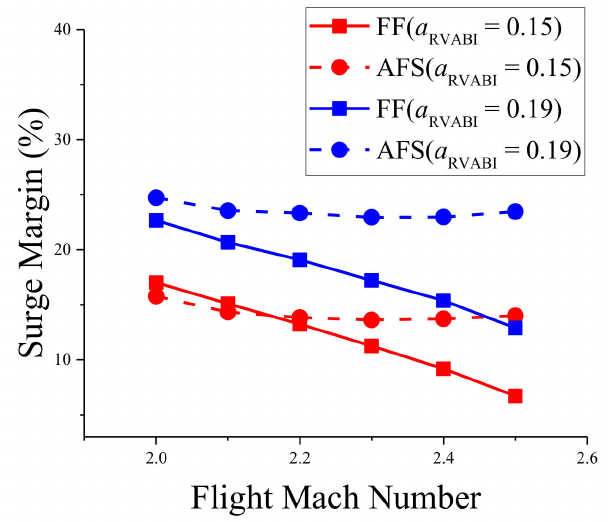
Figure 31. The Variations of Surge Margins of Front Fan and AFS at the conditions of Different Area Coefficients of RVABI ( α RVABI